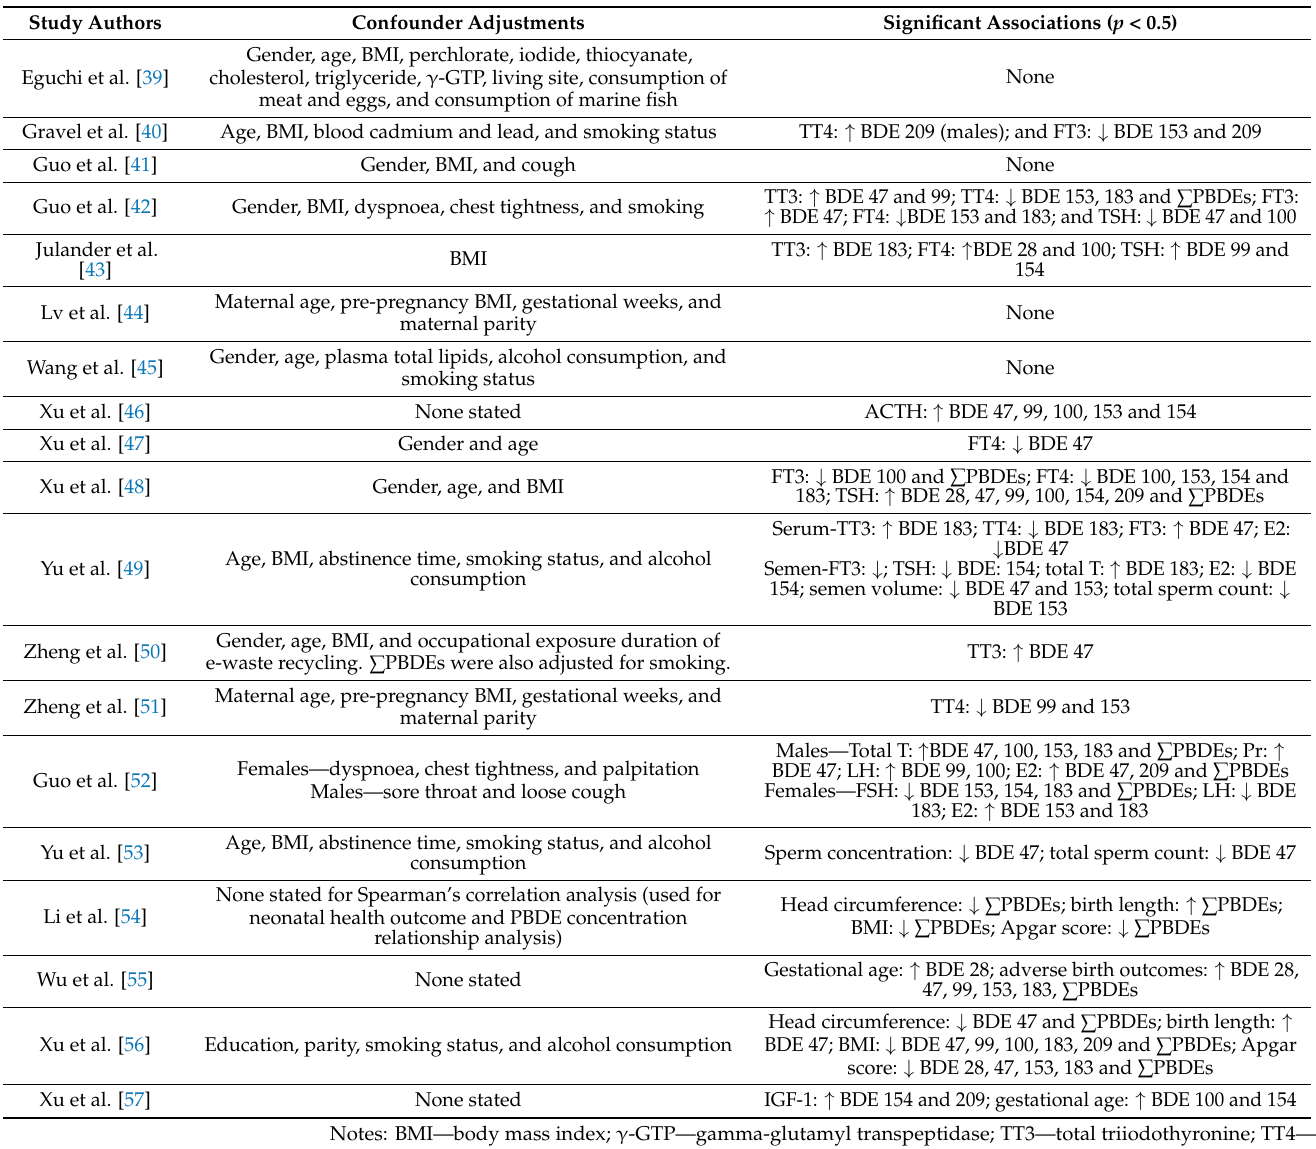
Table 2. Confounder adjustments and statistically significant findings ( p < 0.05) of the studies selected in the